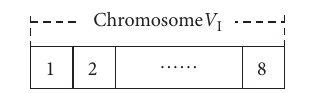
Figure 4: GA chromosome model with single waypoint